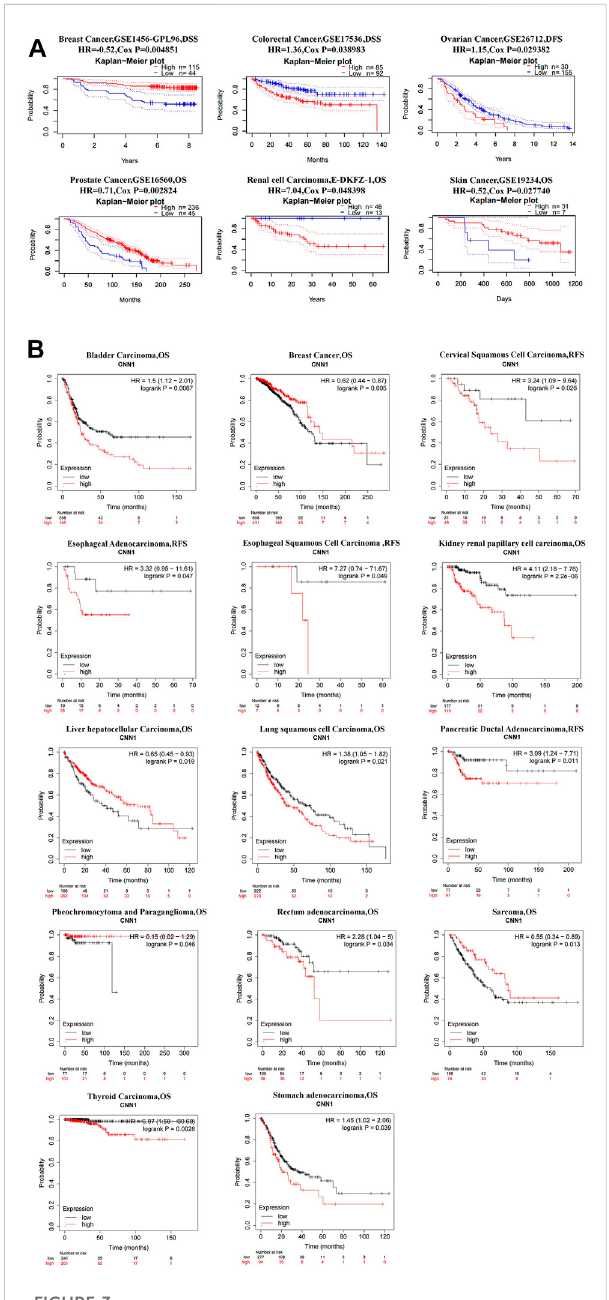
FIGURE 3 Prognostic analysis of CNN1 in pan-cancer. (A) Prognostic analysis of CNN1 in pan-cancer based on the PrognoScan database. (B) Prognostic analysis of CNN1 in pan-cancer based on the Kaplan – Meier plotter